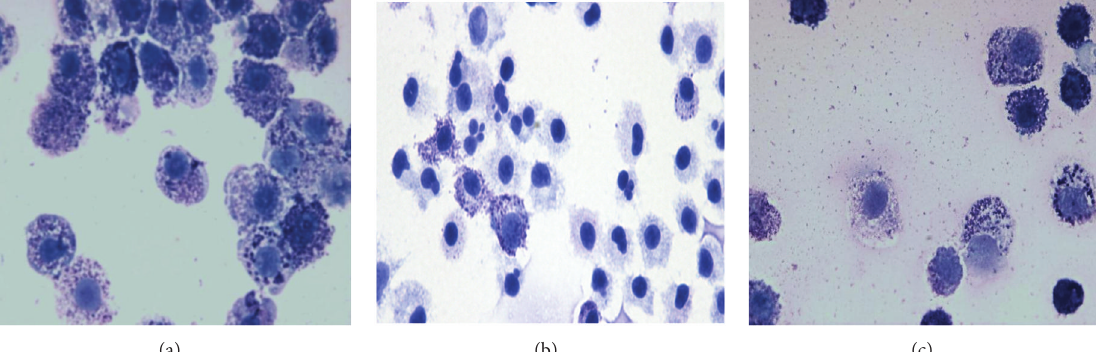
Figure 1: Long-term culture in presence of CSM reduces the density of mast cell granules. BMMCs from BALB/c mice were cultured in presence with medium only (a), CSM (1.5%) (b), or LPS (c) (1 𝜇 g/mL) during the third week of culturing bone marrow cells as described in Section 2. Cells were stained with toluidine